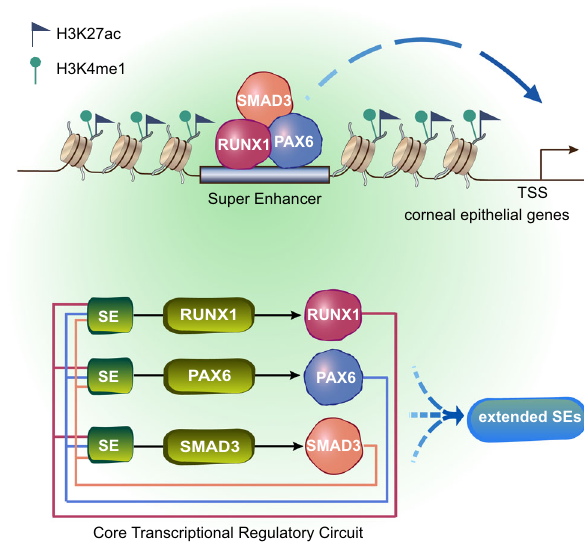
Fig. 7 The CRC model of lineage-determining TFs underling corneal epithelial identity. RUNX1/PAX6/SMAD3 complex governs their own SEs and a broader SE network, establishing the active chromatin environment to maintain expression of the corneal epithelial identity